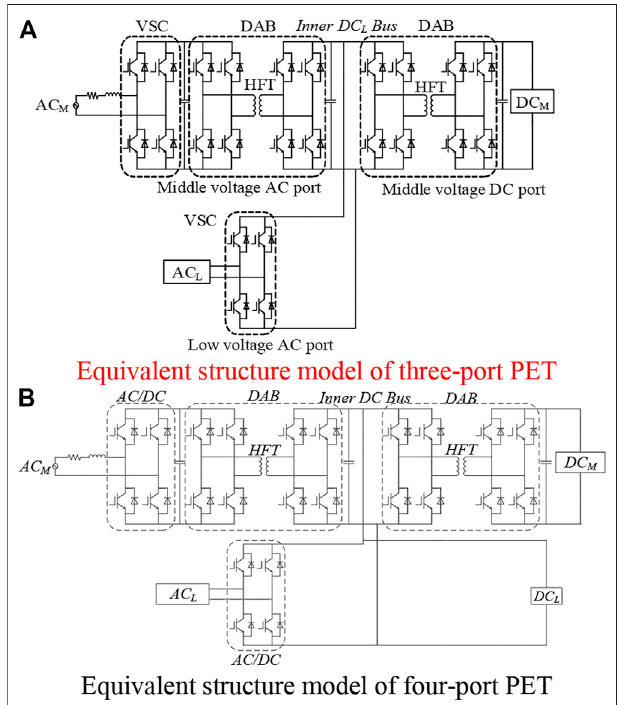
FIGURE 1 | Equivalent structure model of four-port PET. (A) Equivalent structure model of three-port PET. (B) Equivalent structure model of four- port